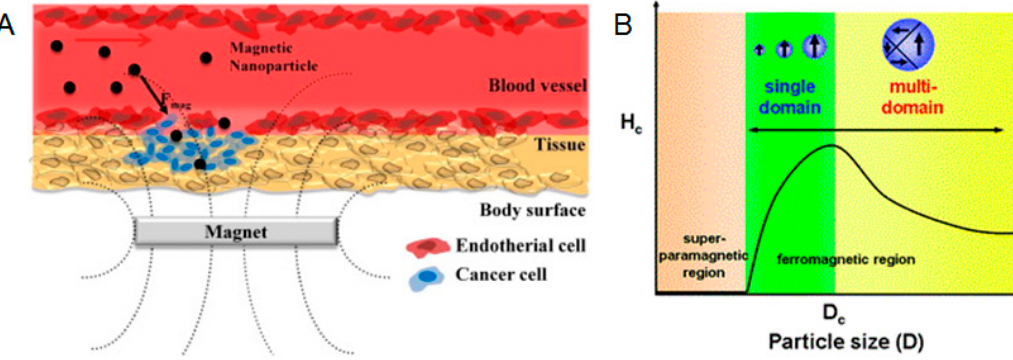
Figure 6. ( A ) Schematic of a magnetic nanoparticle-based drug-delivery system; ( B ) Plot of the magnetic coercivity (Hc) vs. the size of particle for drug delivery. (Reproduced with permission from Reference [98], Elsevier, and Reference [99], The Royal Society of Chemistry).